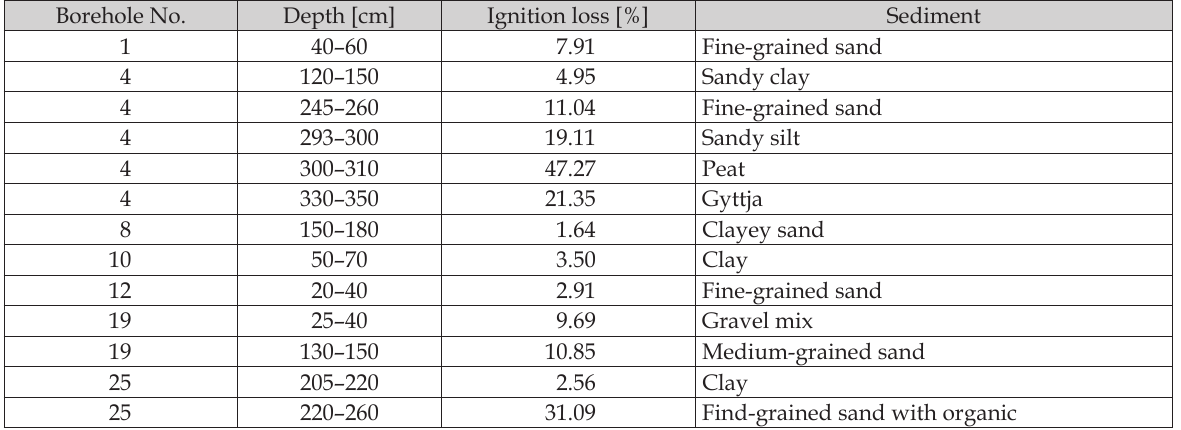
Table 2. Loss on ignition analysis of different samples with visible organic matter. Borehole No.